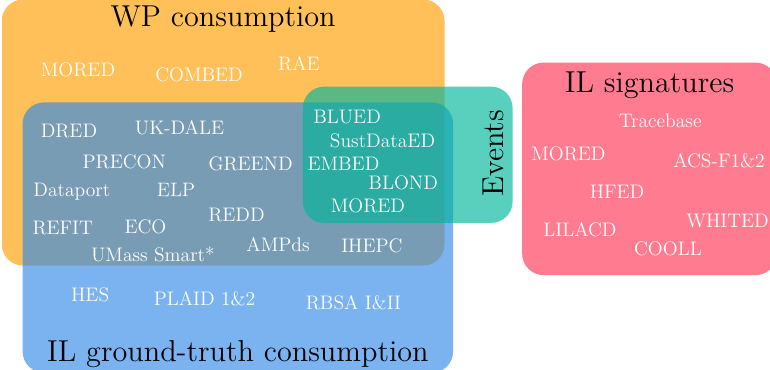
Figure 2. Venn diagram of a taxonomy based solely on the provided types of